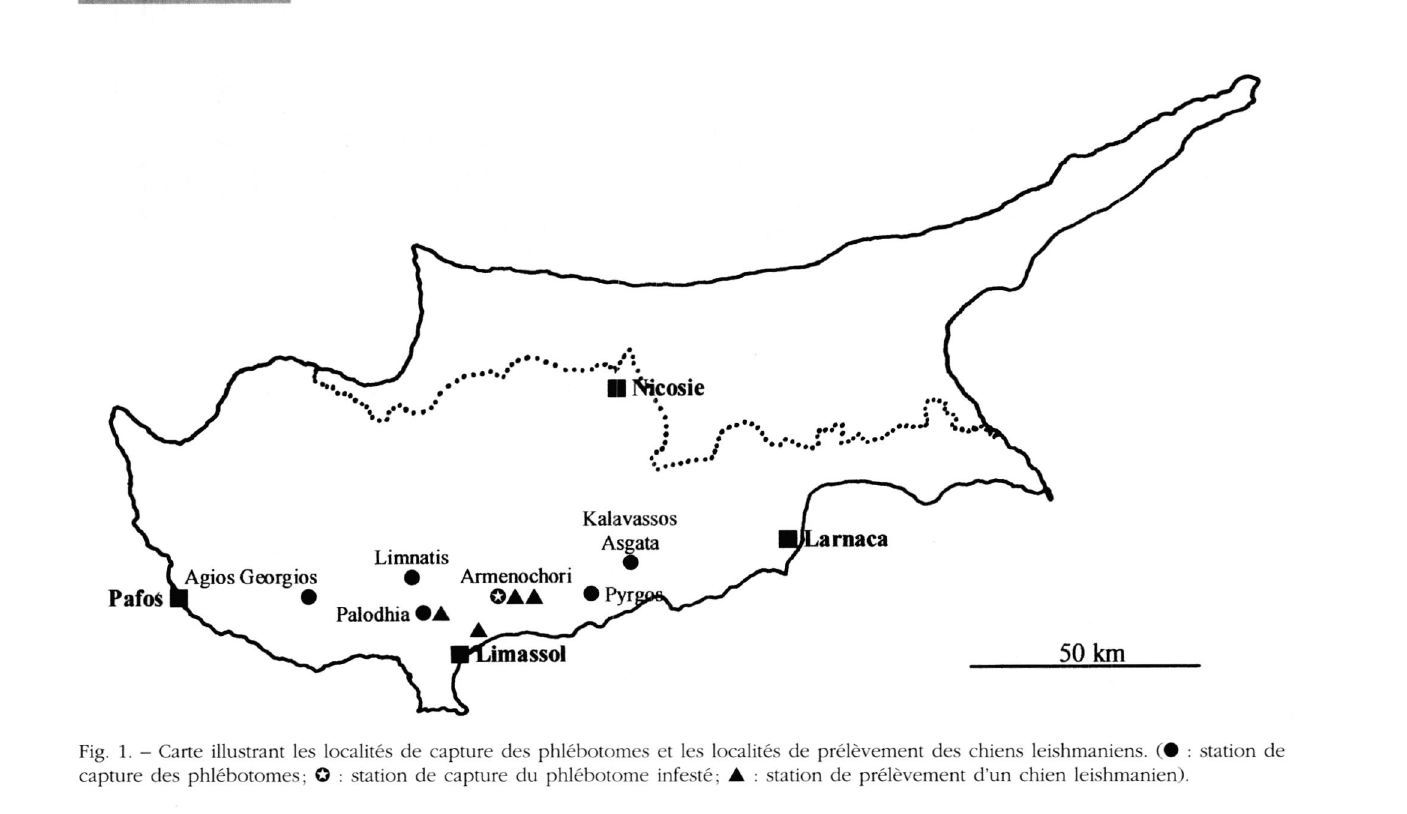
Les localités de capture des phlébotomes (Fig. 1) ont été choisies en fonction des cas récents de leishma niose canine observés (Deplazes et al., 1998;